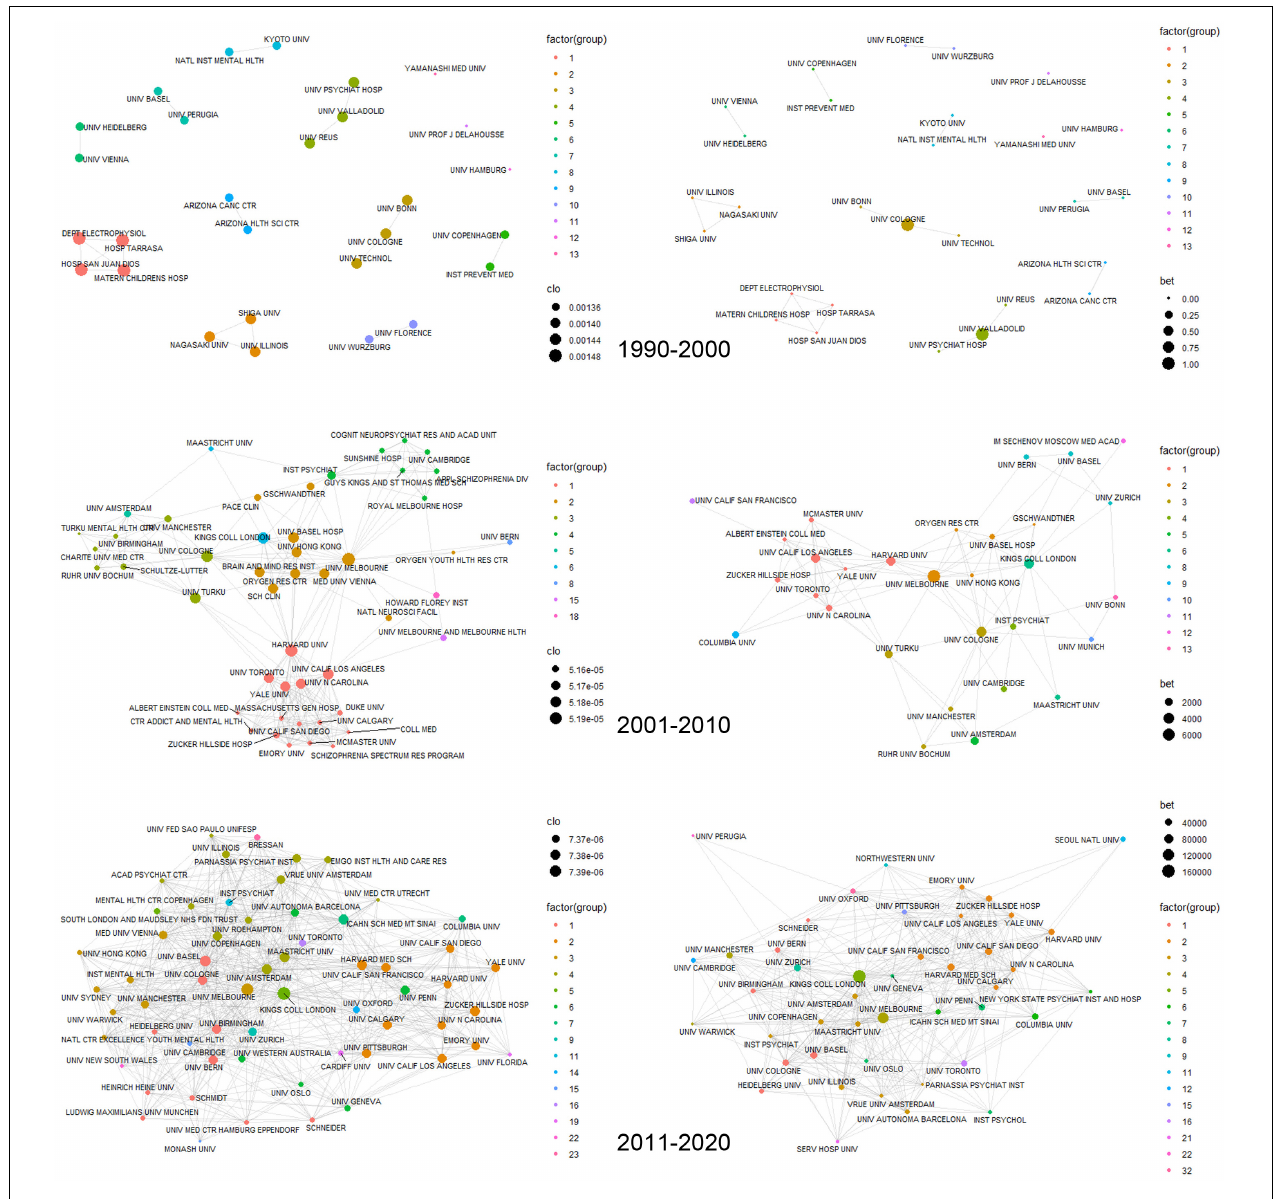
FIGURE 3 | The collaboration network among the research institutions over a decade. The figure on the left is the closeness centrality and the figure on the right is the betweenness